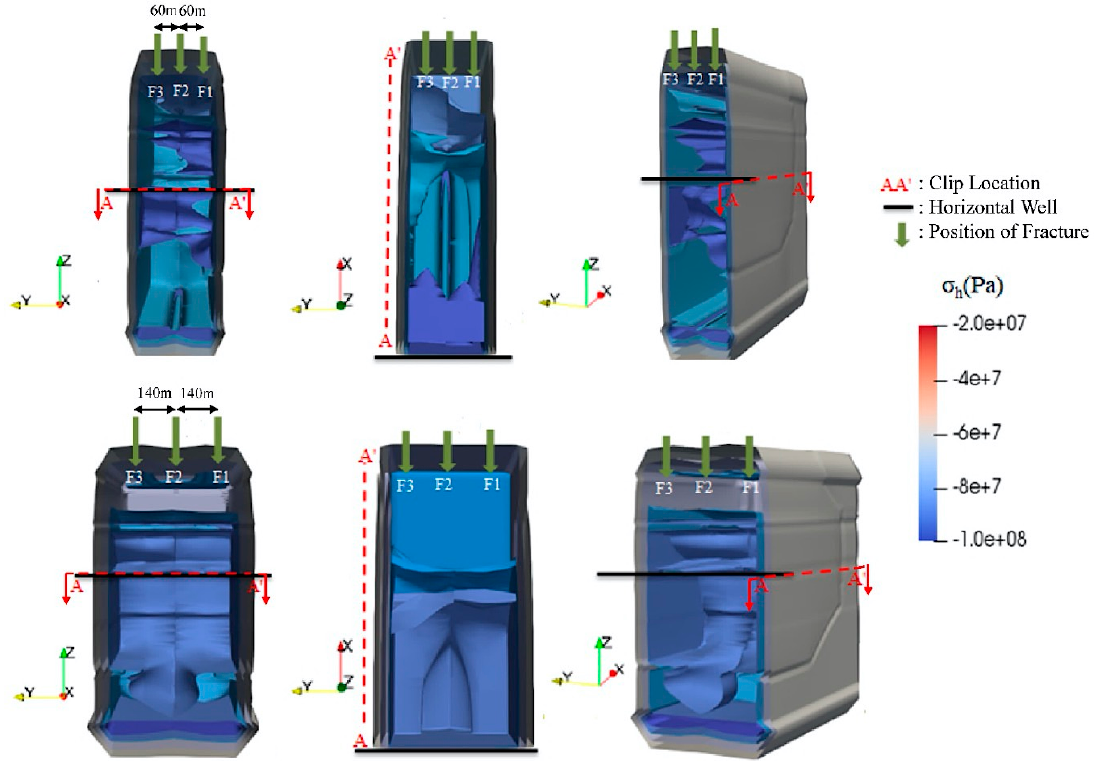
Figure 18. Iso-surface contours of minimum horizontal stress in 60 and 140 m fracture spacing models.